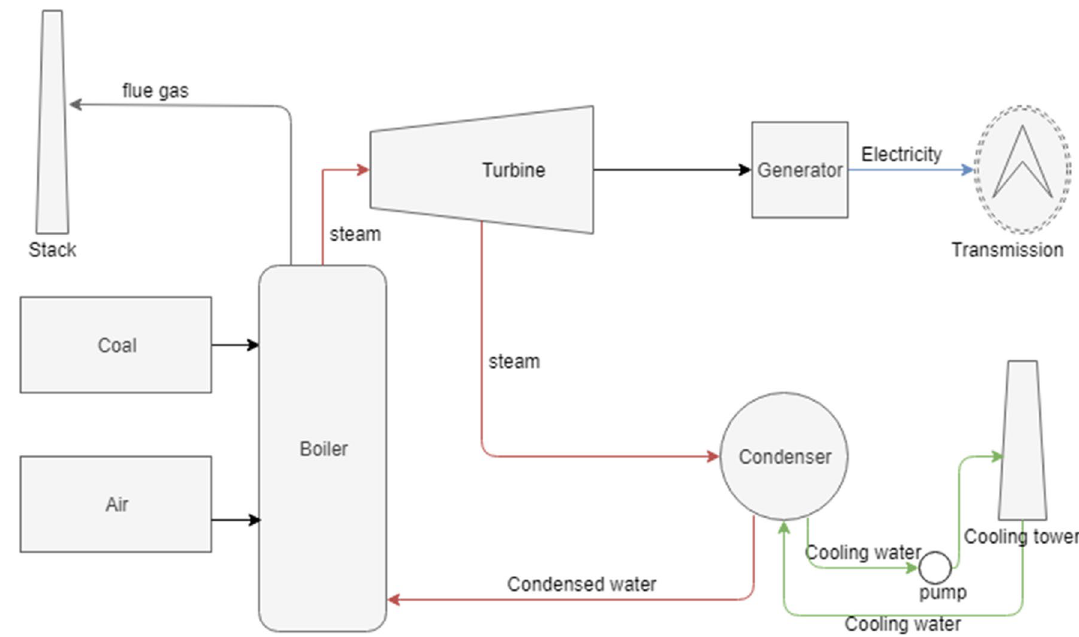
Fig. 2 Schematic diagram of TPP with